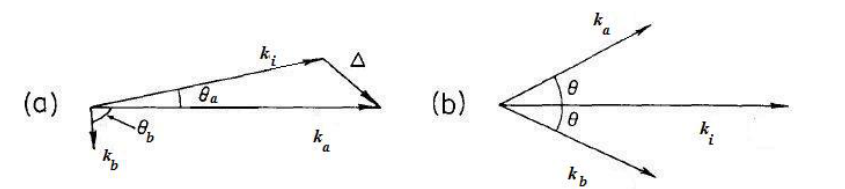
Figure 2. Schematic diagrams of the kinematics of ( a ) a coplanar asymmetric and ( b ) a coplanar symmetric (e, 2e) reaction. The vector ∆ = k i − k a is the momentum transfer. In the symmetric case θ = θ a = θ